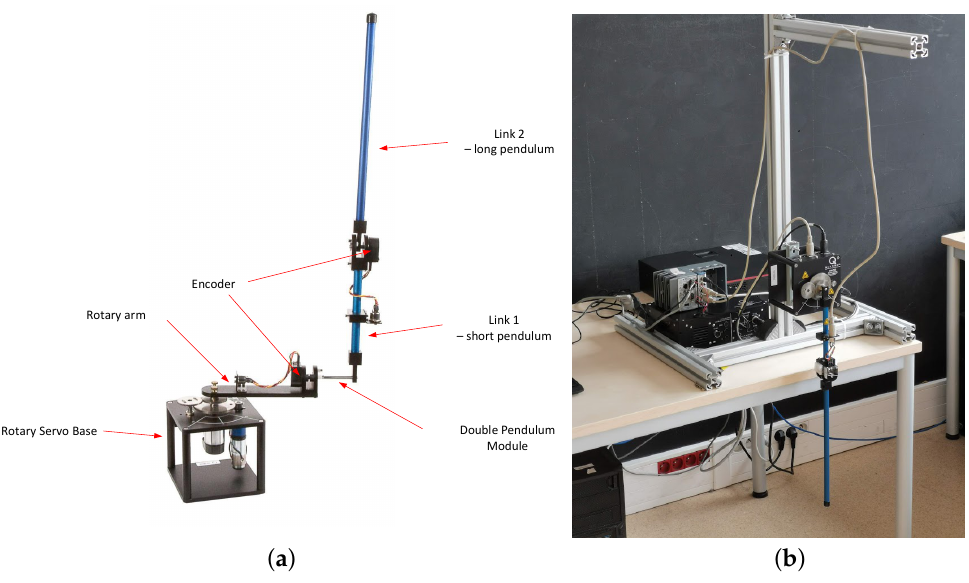
Figure 5. Experimental test-bed: ( a ) original plant, ( b ) used